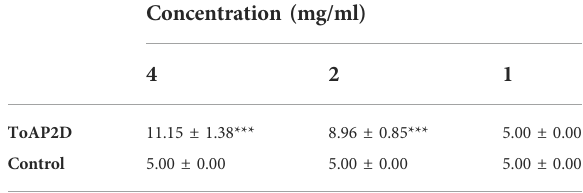
TABLE 1 Antifungal diameter of antimicrobial peptides in vitro .